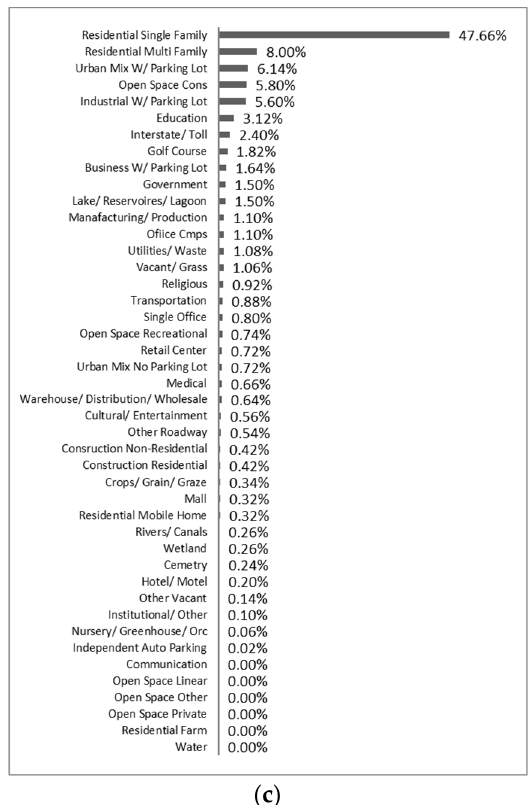
Figure 6. Percentages of ( a ) land use area, ( b ) total nitrogen loads, and ( c ) total phosphorous loads in the Upper Chicago River Basin.